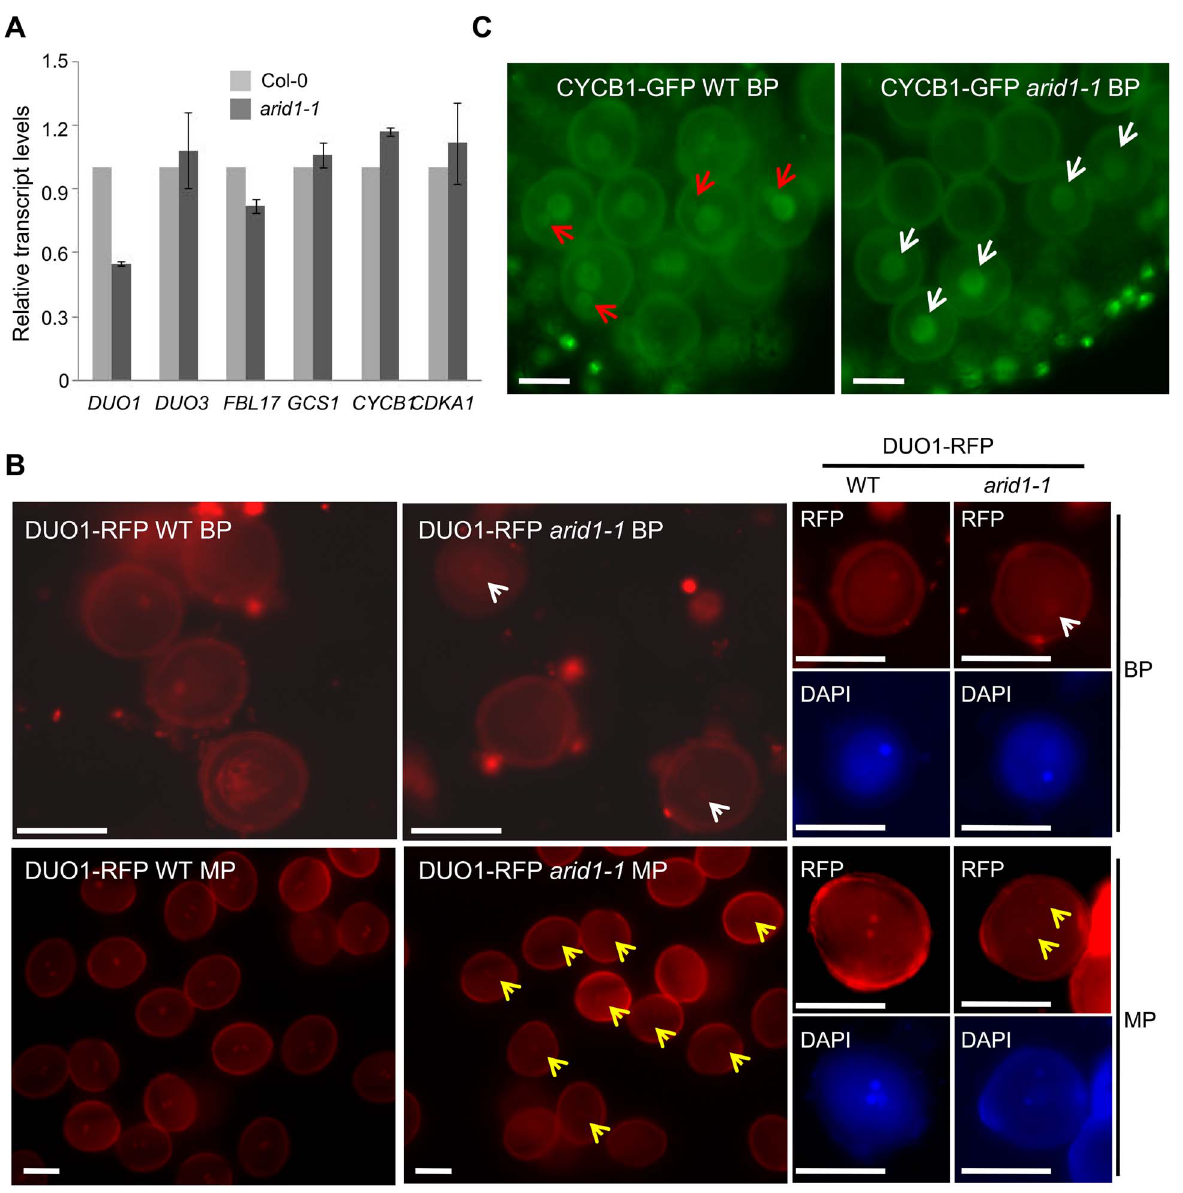
Figure 2. Reduced DUO1 and CYCB1 expression in arid1-1 . (A) Expression of sperm-specific genes in mature pollen of wild type and arid1-1 . Error bars represent the SE from the mean of three biological replicates. (B) Expression of DUO1-RFP in wild type and arid1-1 . Representative images for each genotype were acquired with the same exposure times. White and red arrows indicate reduced DUO1-RFP signal in bicellular pollen and mature pollen, respectively. Scale bar, 10 m m. (C) Expression of CYCB1-GFP in the bicellular pollen of wild type and arid1-1 , respectively. The red arrows indicate visible GFP accumulation of CYCB1 in the generative nucleus of wild type pollen, and the white arrows indicate unchanged GFP signal in the vegetative nuclei of the arid1-1 pollen. Scale bar, 10 m m. transgenic plants with ARID1 driven by LAT52 (LAT52:ARID1), a vegetative cell-specific promoter, and HTR10 (HTR10:ARID1), a generative cell and sperm cell-specific promoter, respectively.